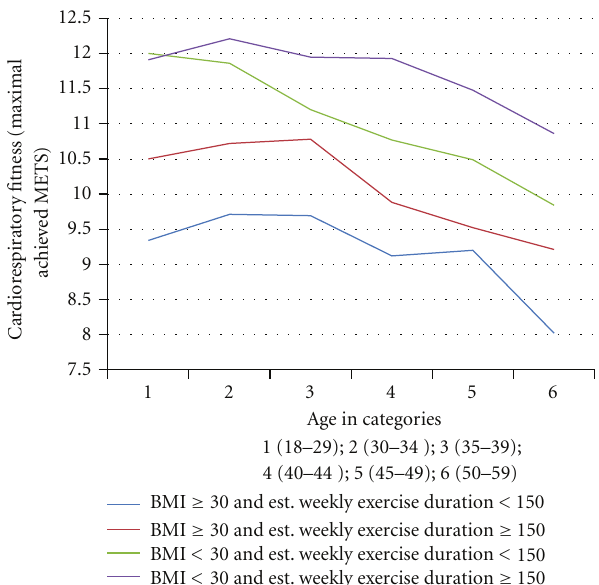
Figure 2: Cardiorespiratory fitness across di ff erent age categories and stratified by BMI/estimated weekly exercise duration.